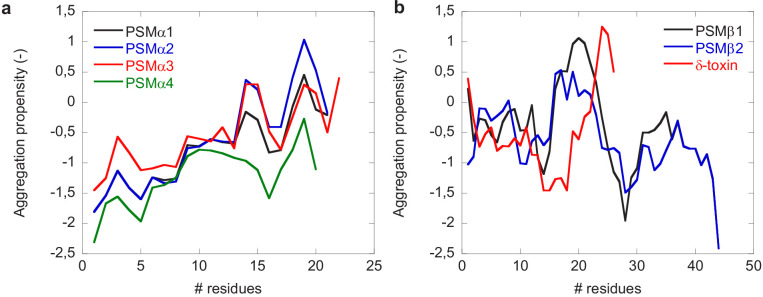
Aggregation propensity profiles of phenol-soluble modulin (PSM) peptides using CamSol.(a) Aggregation propensities of PSMα group of peptides (PSMα1, PSMα2, PSMα3, and PSMα4). (b) Aggregation propensity of PSMβ group of peptides (PSMβ1 and PSMβ2) along with δ-toxin.
Figure 4—figure supplement 2—source data 1.Source data for aggregation propensities of phenol soluble modulins.